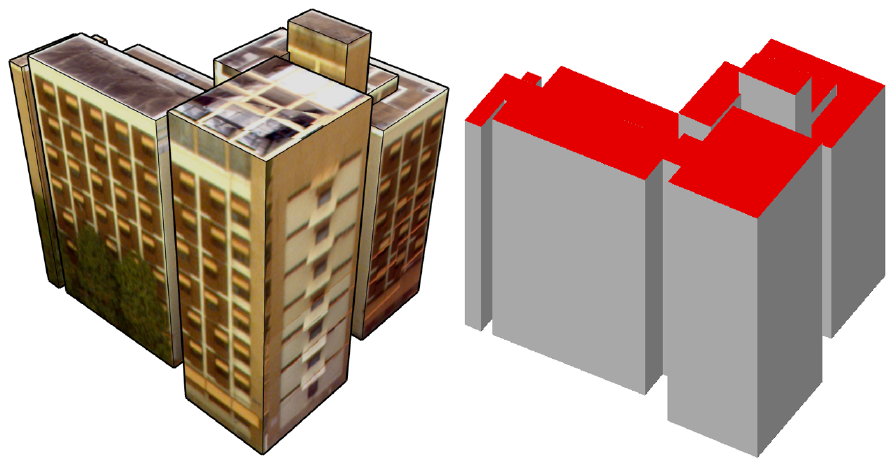
Figure 24. A building model and its semantic information for comparisons among VSE, CityEditor, and CityGML